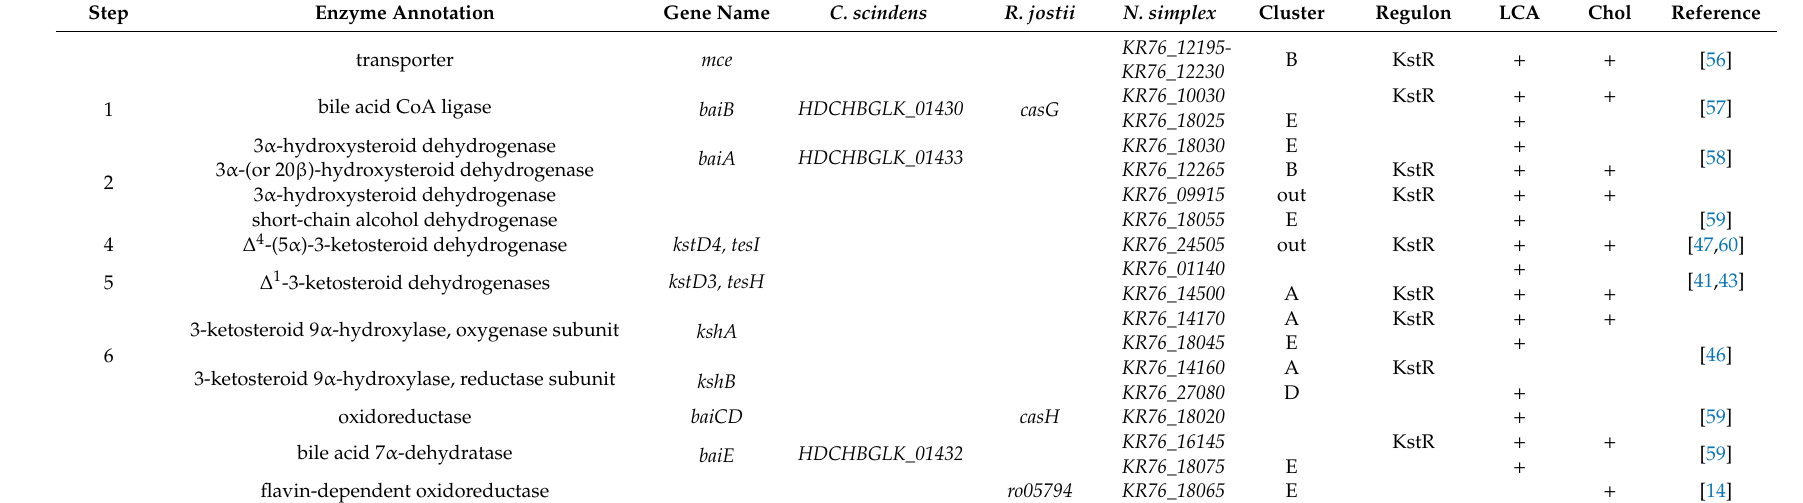
Table 4. Candidate genes for initial steps of cholate degradation and cholic acids